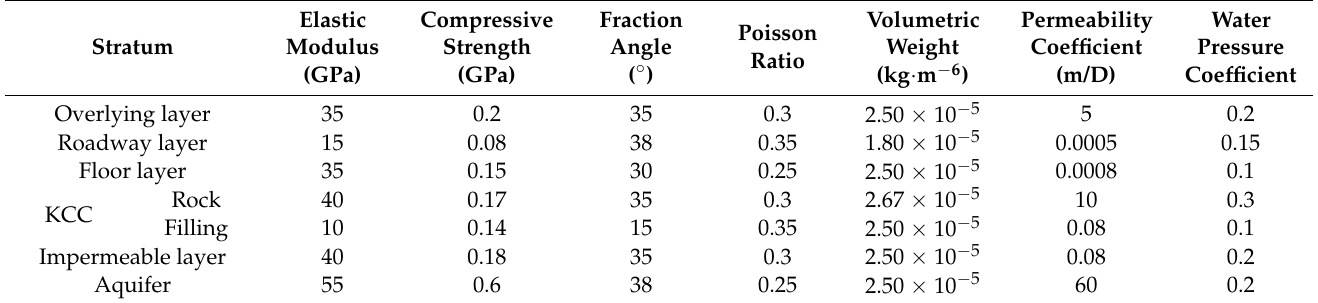
Table 1. Properties and mechanical parameters of each rock layer in the RFPA model.